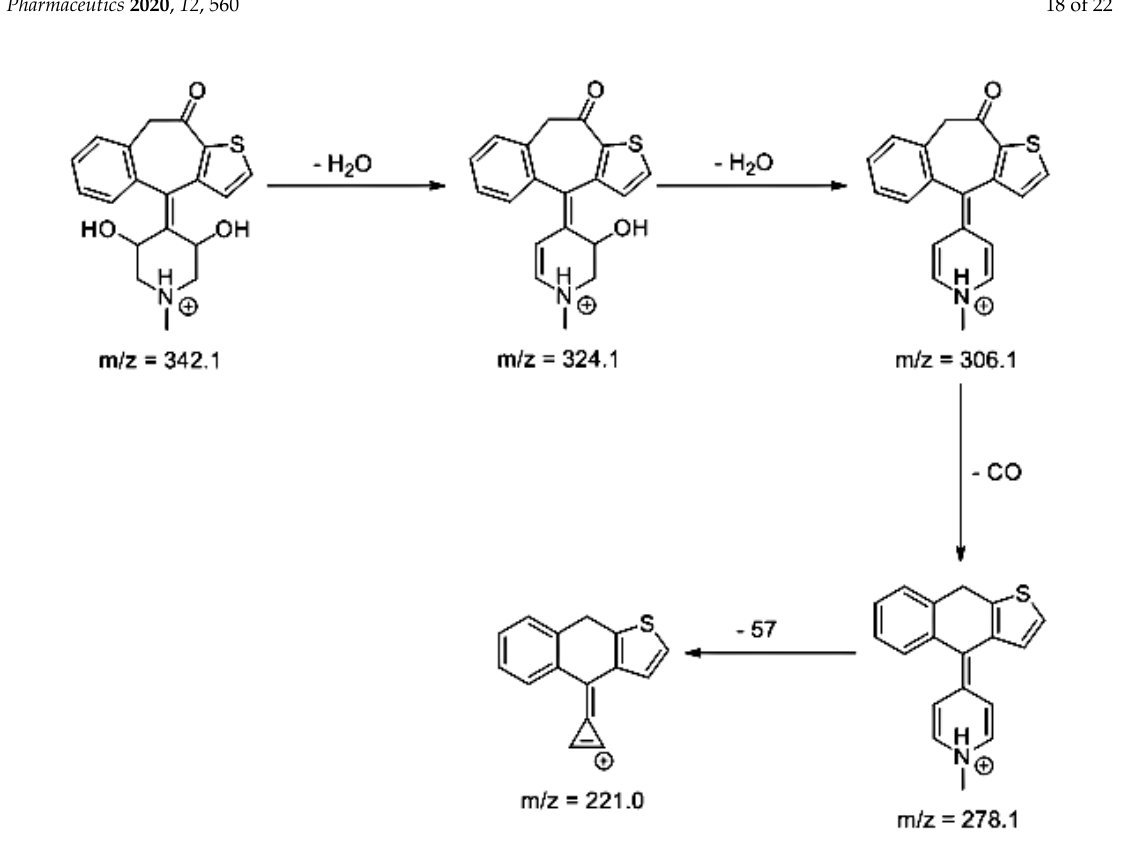
Figure 13. Proposed fragmentation pattern of KET-P3.